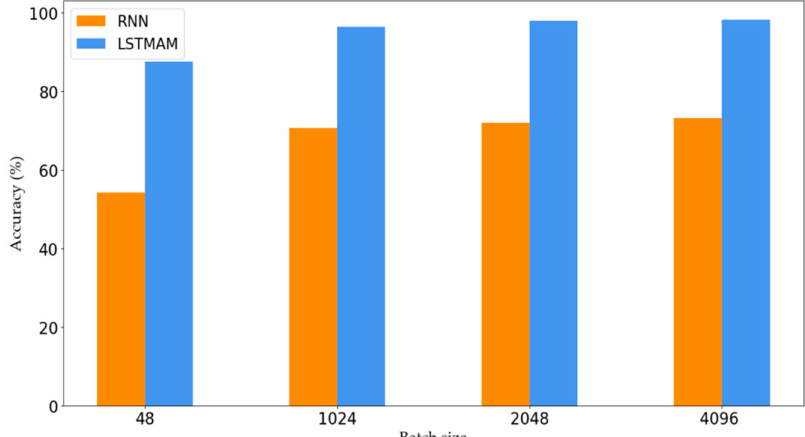
Figure 12. The accuracies of recurrent neural network (RNN) and LSTM with attention mechanism (LSTMAM) with di ff erent Batch size.